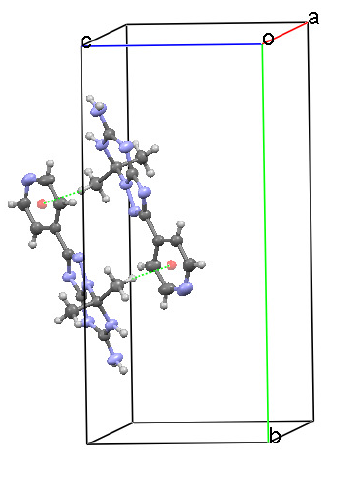
Figure 5. A dimer formed by the molecules 1 via the CH··· π